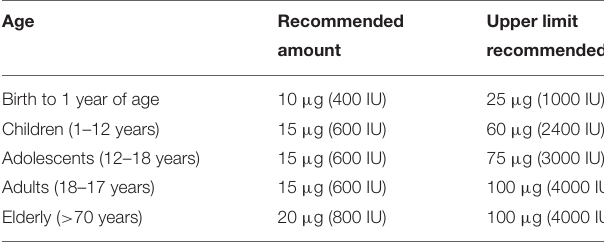
TABLE 2 | Current age-related recommended daily vitamin D supplementation levels [references (17, 86–90)]. Age Recommended Upper limit amount